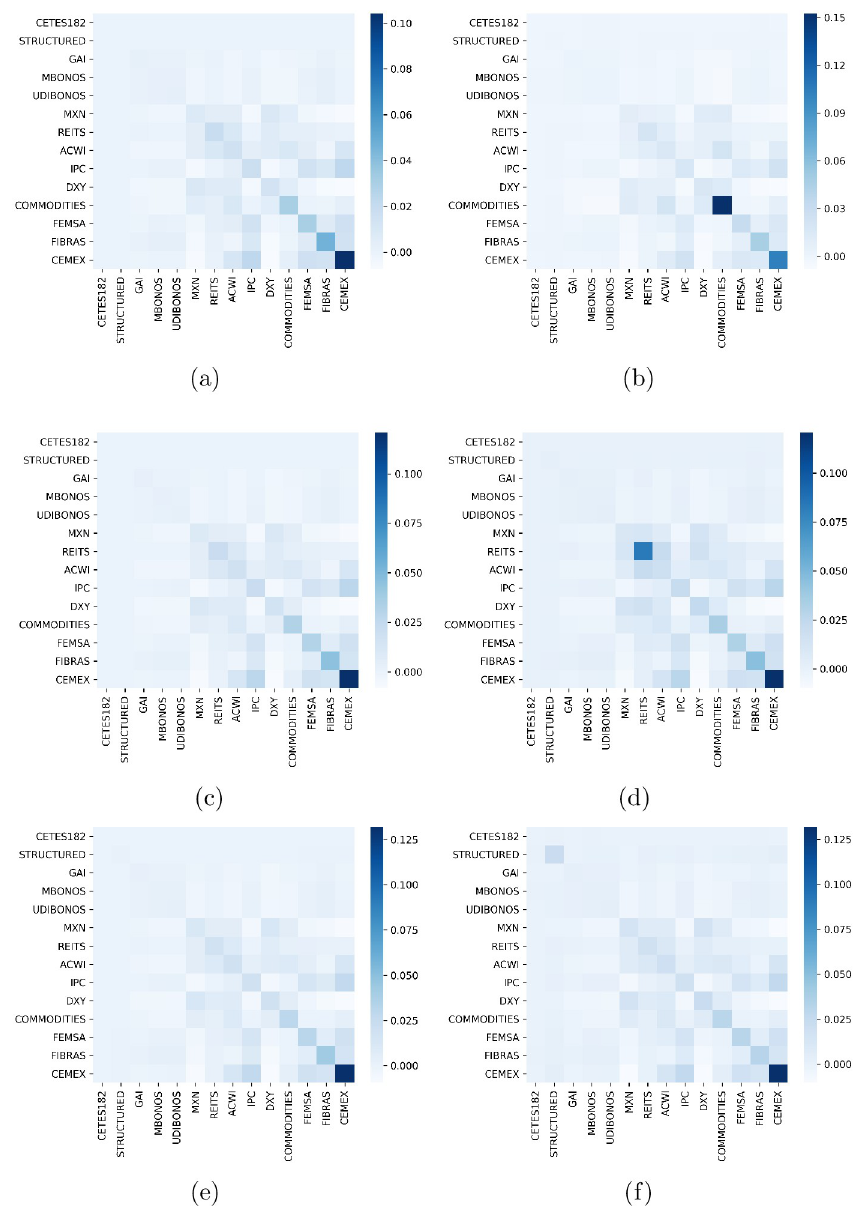
Fig 4. Estimated covariance matrices under DCC-GARCH(1,1). Top, univariate EGARCH specification at t = 1, 40 years ((a) and (b), respectively). Middle, univariate GJR-GARCH specification at t = 1, 40 years ((c) and (d), respectively). Bottom, univariate GARCH specification at t = 1, 40 years ((e) and (f),